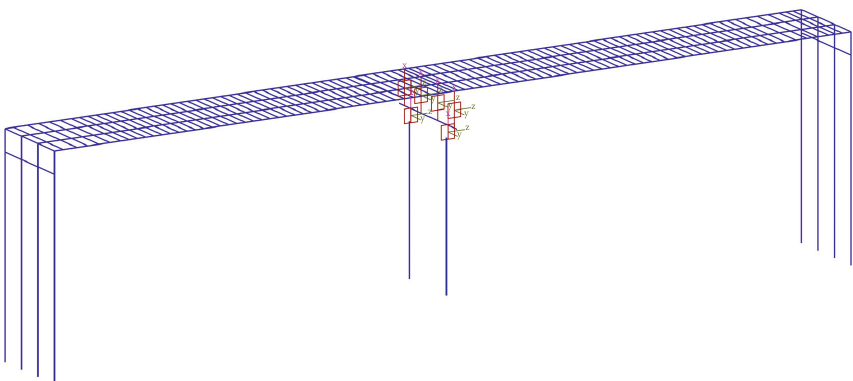
Figure 19: FEM of Shangban Bridge.